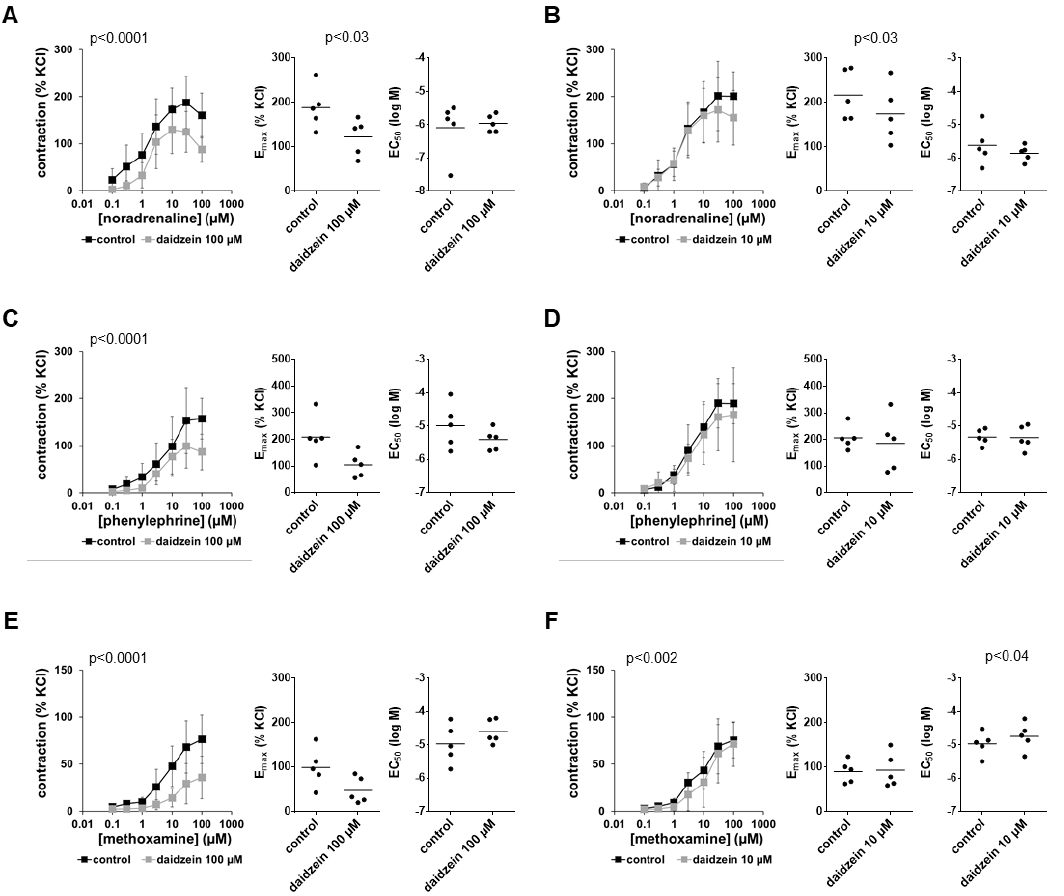
Figure 3. Effects of daidzein on α 1 -adrenergic contractions of human prostate tissues.